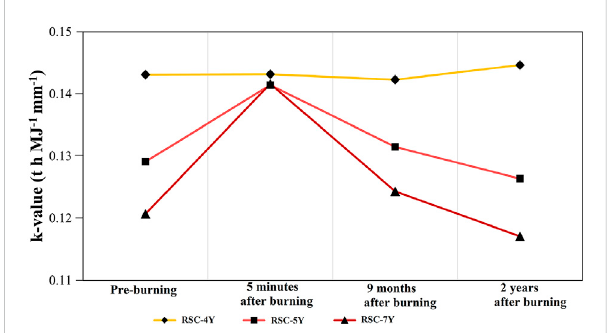
FIGURE 4 k -values (t h MJ − 1 mm − 1 ) before burning and at 5 min, 9 months, and 2 years after burning in three fallow fi elds.